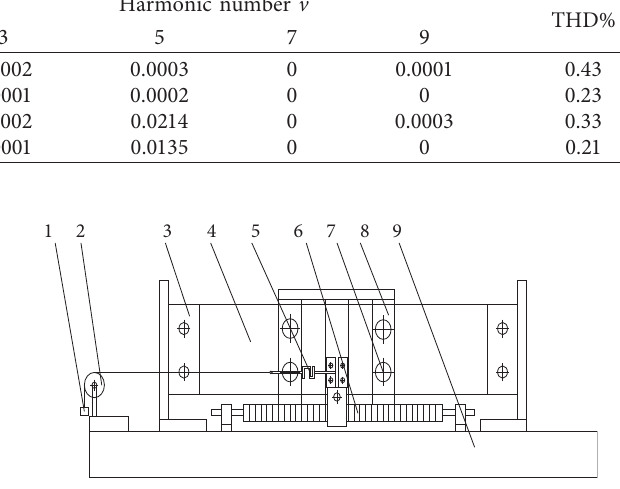
Figure 19: Thrust fluctuation test scheme: (1) load; (2) pulley; (3) support frame; (4) static guide rail; (5) force sensor; (6) new